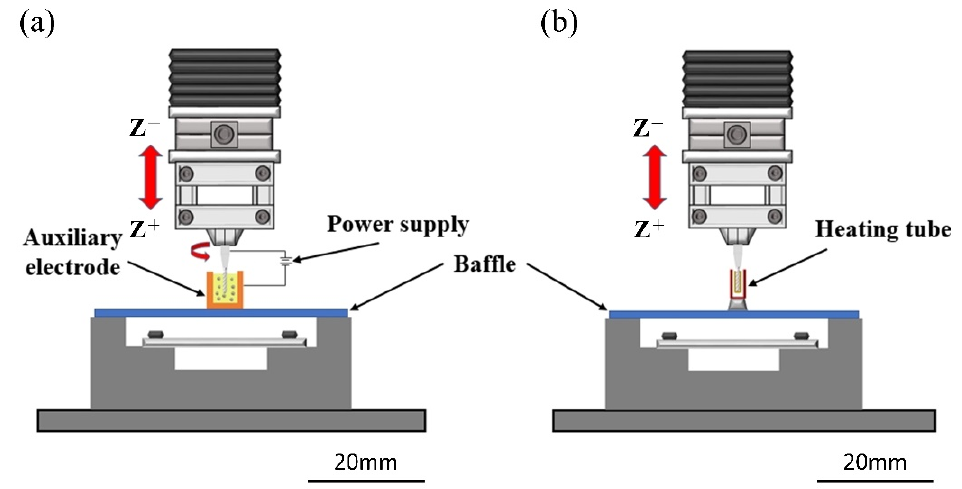
Figure 1. Schematic diagram of the µ-EDD experimental setup.